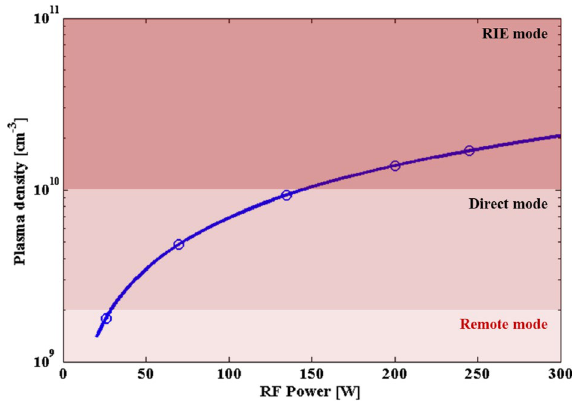
Figure 4. Plasma density and mode depending on the RF power.